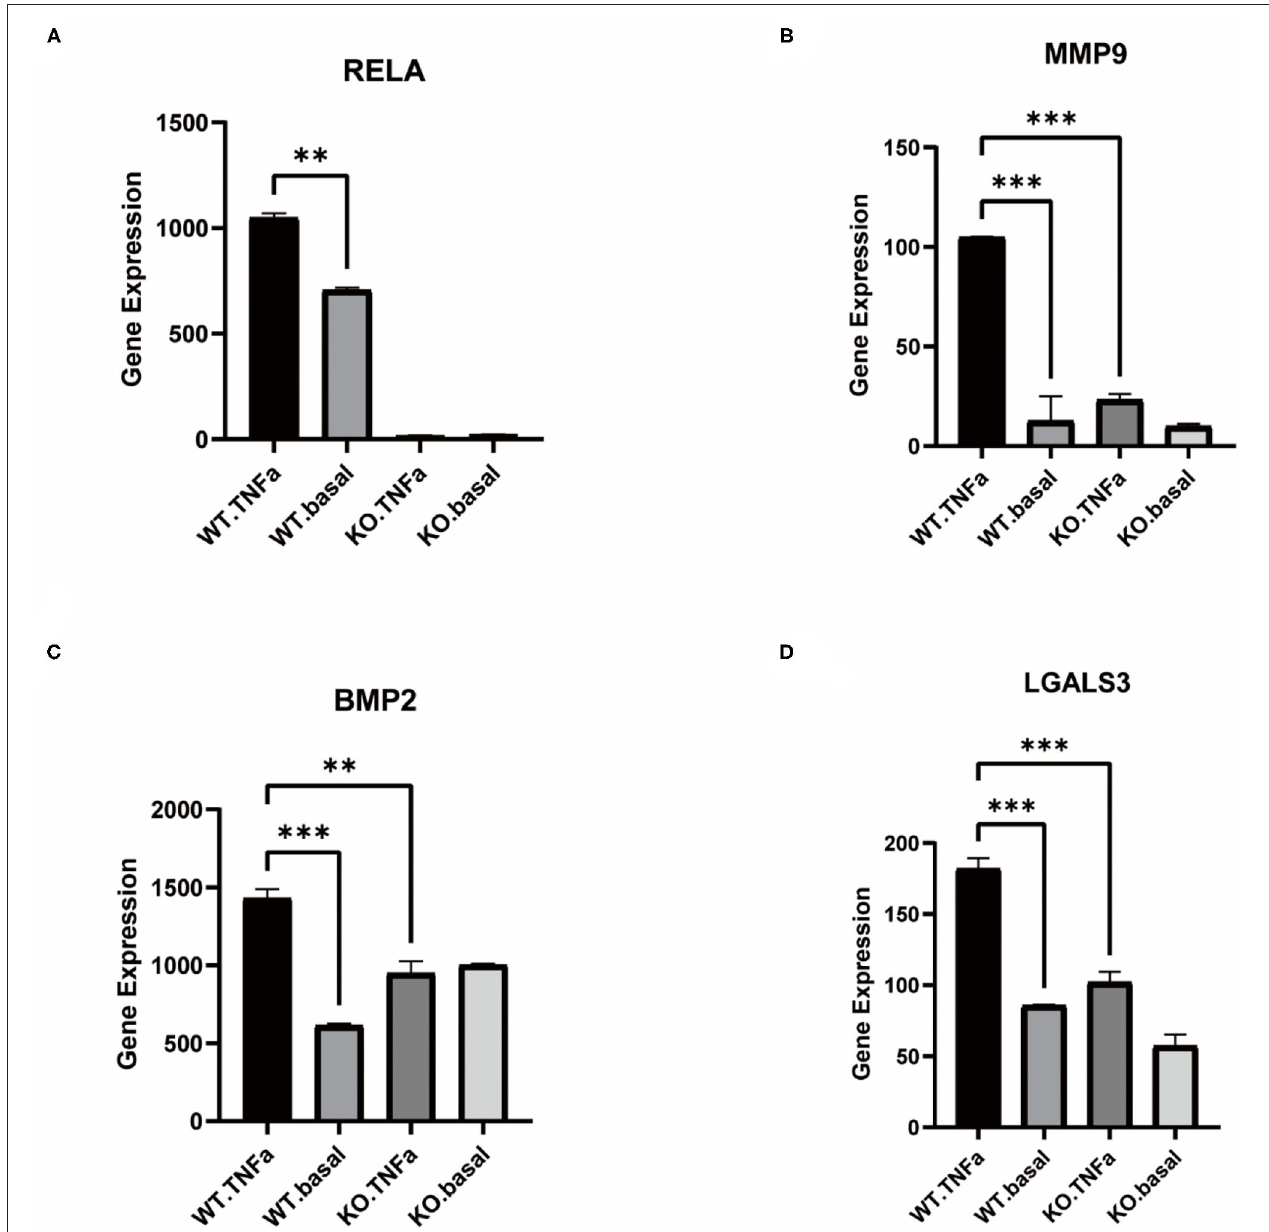
FIGURE 4 | Comparison of gene expression in VSMCs before knockdown of RELA and after knockdown. (A–D) Expression of RELA, MMP9, BMP2 and LGALS3 in control and TNF α -added groups after knockdown vs. before knockdown, respectively. ** P < 0.01, *** P < 0.001.